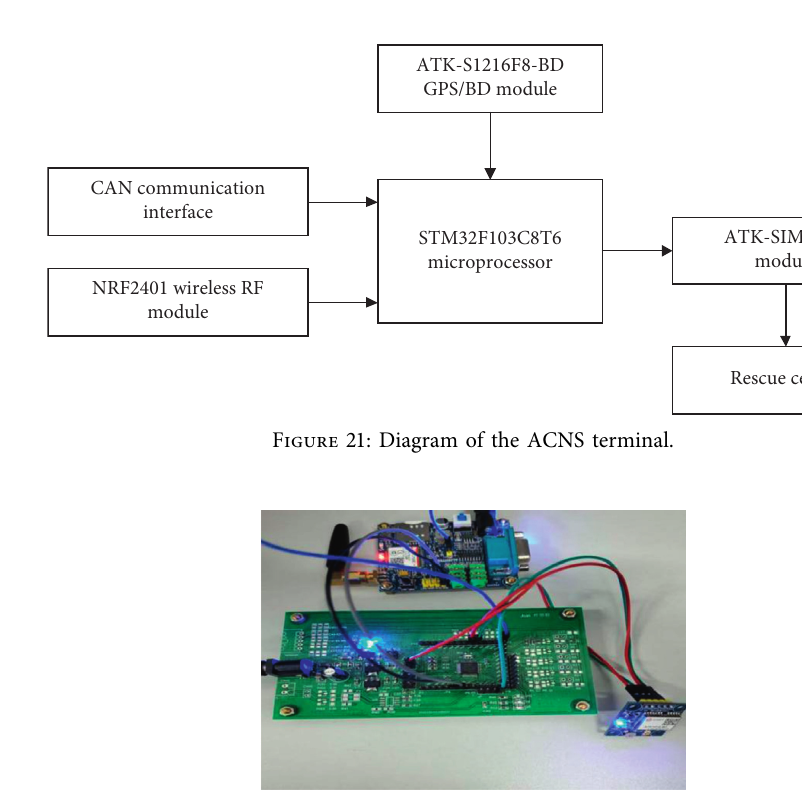
Figure 20: Acceleration curve of the real vehicle crash test.